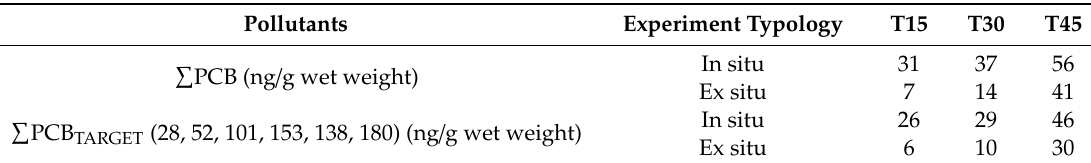
Table 5. Percentage increase (%) of PCBs (sum of congeners) at T15, T30, and T45 in reference to T0 for the in situ and ex situ bioaccumulation tests